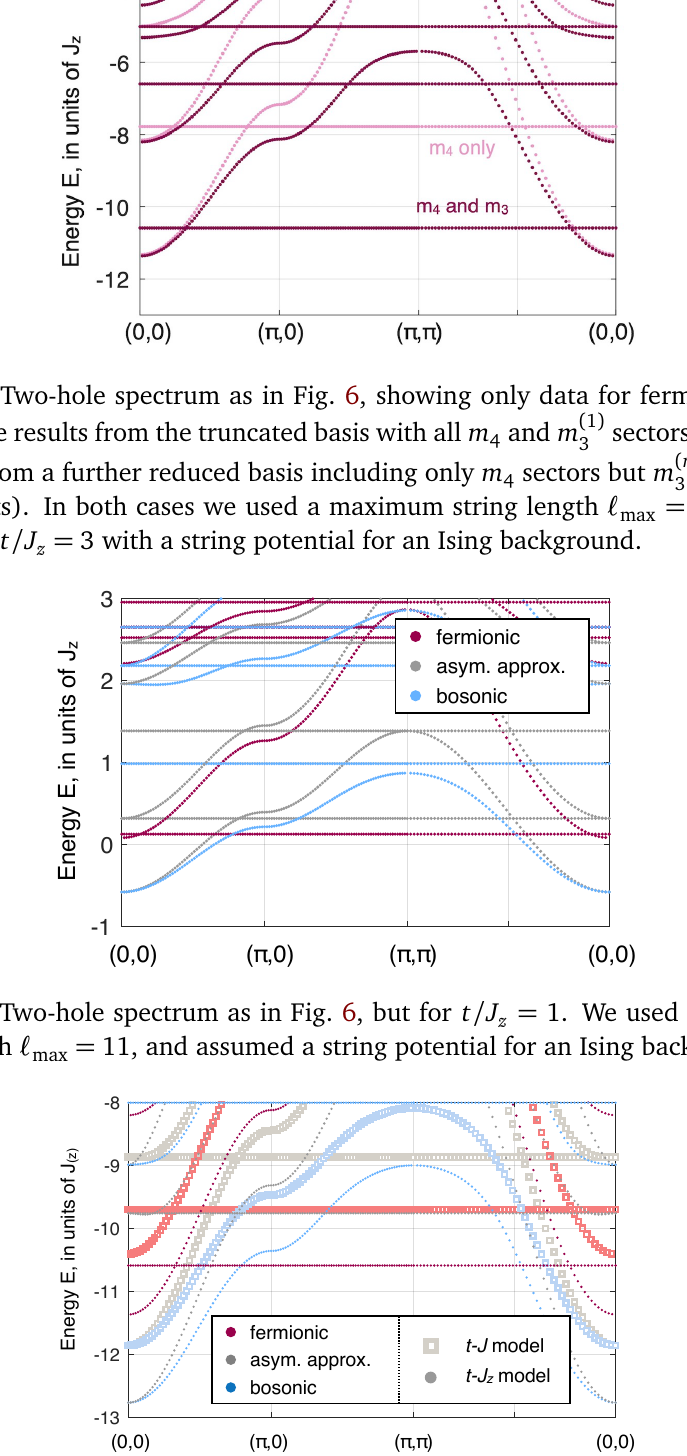
Figure 18: Two-hole spectrum as in Fig. 6, comparing the previous t − J spectral lines calculated for a string-tension Eq. (16) calculated for a weakly doped = 0). We assumed t / J t − J model (with J 2 = string length ℓ max